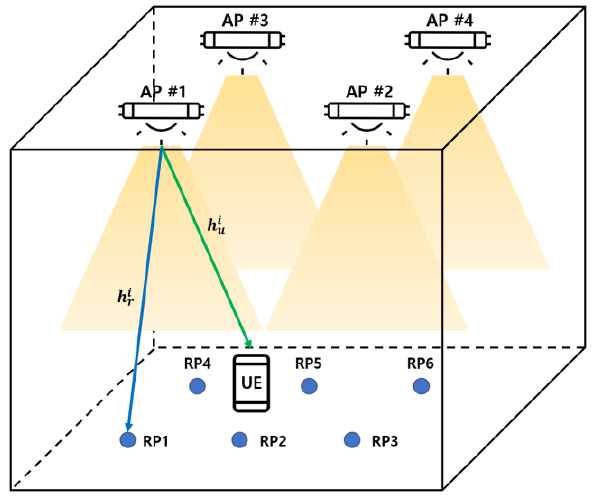
Figure 1. Indoor VLC environment configuration.